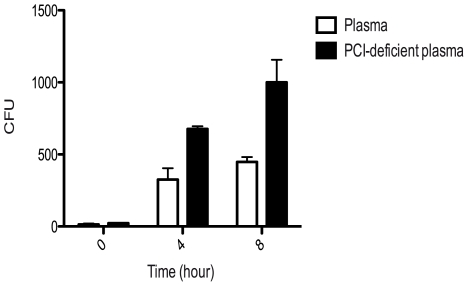
PCI inhibits bacterial growth in plasma.
S. pyogenes strain AP1 was grown in normal human plasma or PCI-deficient plasma at 37°C for 8 h. Bacterial growth was then followed by plating appropriate dilutions of the bacterial solutions on TH agar plates at the indicated time points. Plates were incubated at 37°C over night and cfus were determined. A representative experiment of 5 is shown.